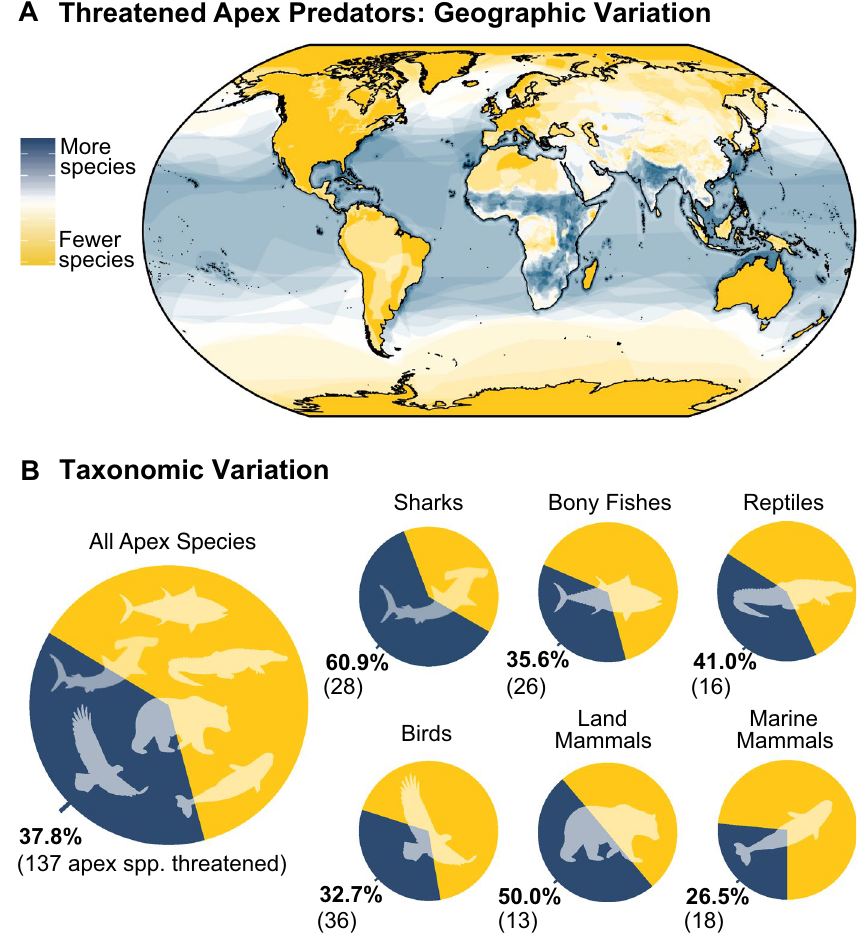
Figure 1. Variation in current large carnivore extinction risk (status). Large carnivores are divided taxonomically into sharks and rays, bony fishes, reptiles and amphibians, birds, terrestrial mammals, and marine mammals. Bold values are the percent threatened in each taxon; values in parentheses are the number of threatened